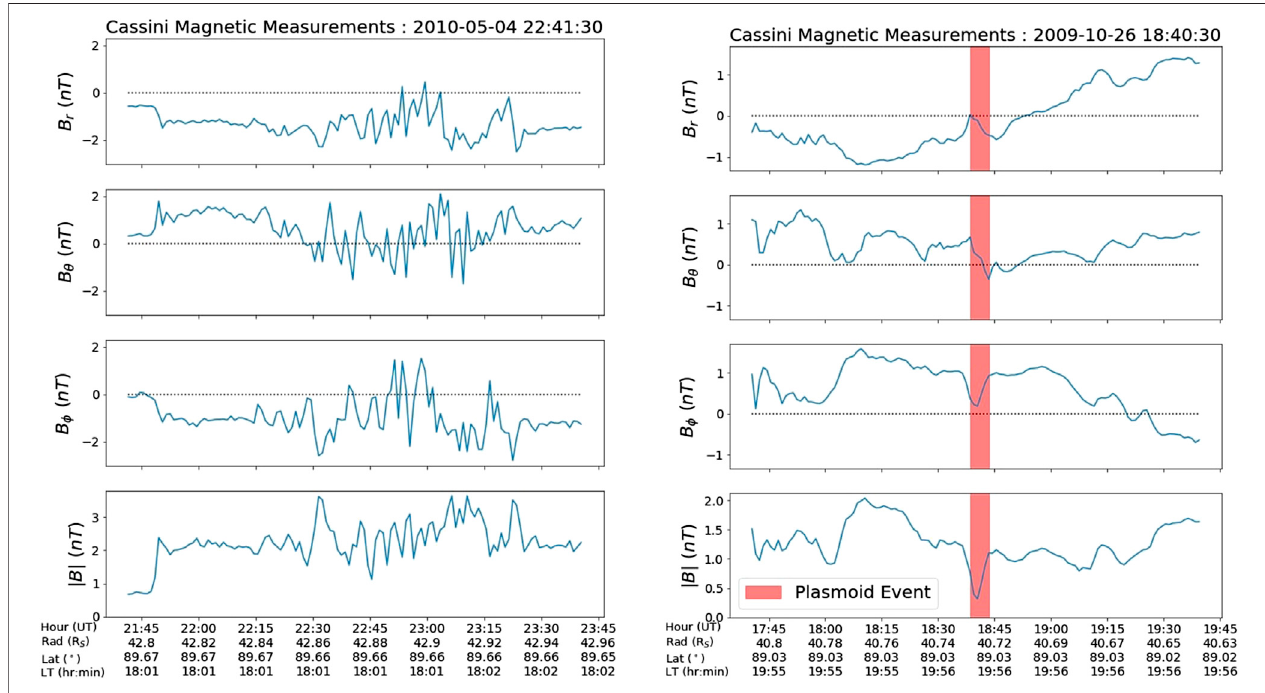
FIGURE4| Examplesofmagnetometerdataforanonevent (left) andevent (right) usedtotrainamachinelearningalgorithm.Titlesoftheseplotsdenotethetime at center of these observing windows in a YYYY-MM-DD format.